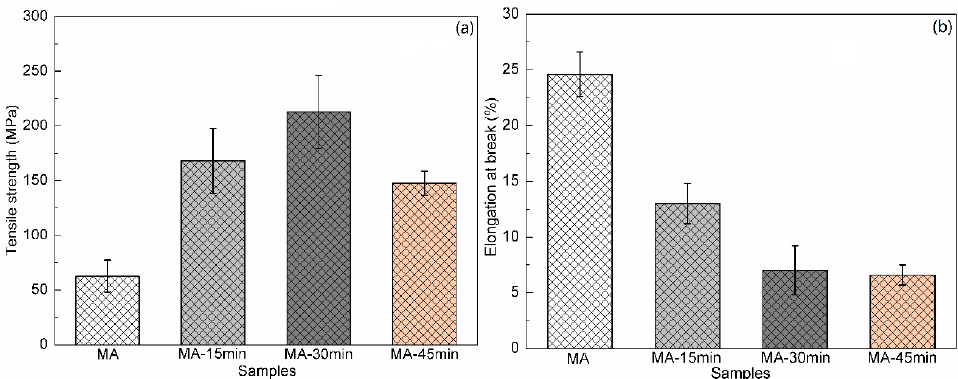
Figure 10. ( a ) Tensile strength and ( b ) elongation at break of MA sample and all-wood biocomposites with different hot-pressing time.